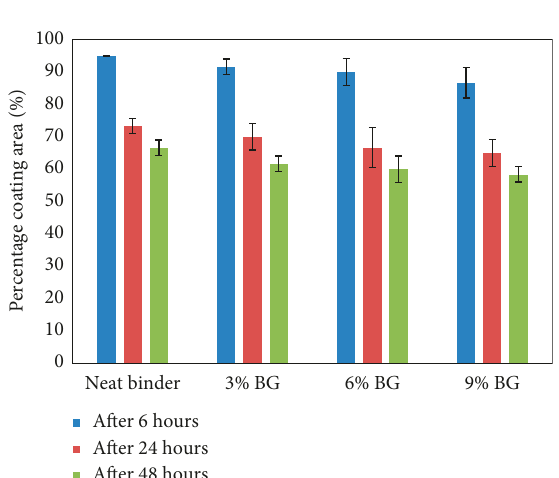
Figure 13: Loss of coating for various BG percentages at different